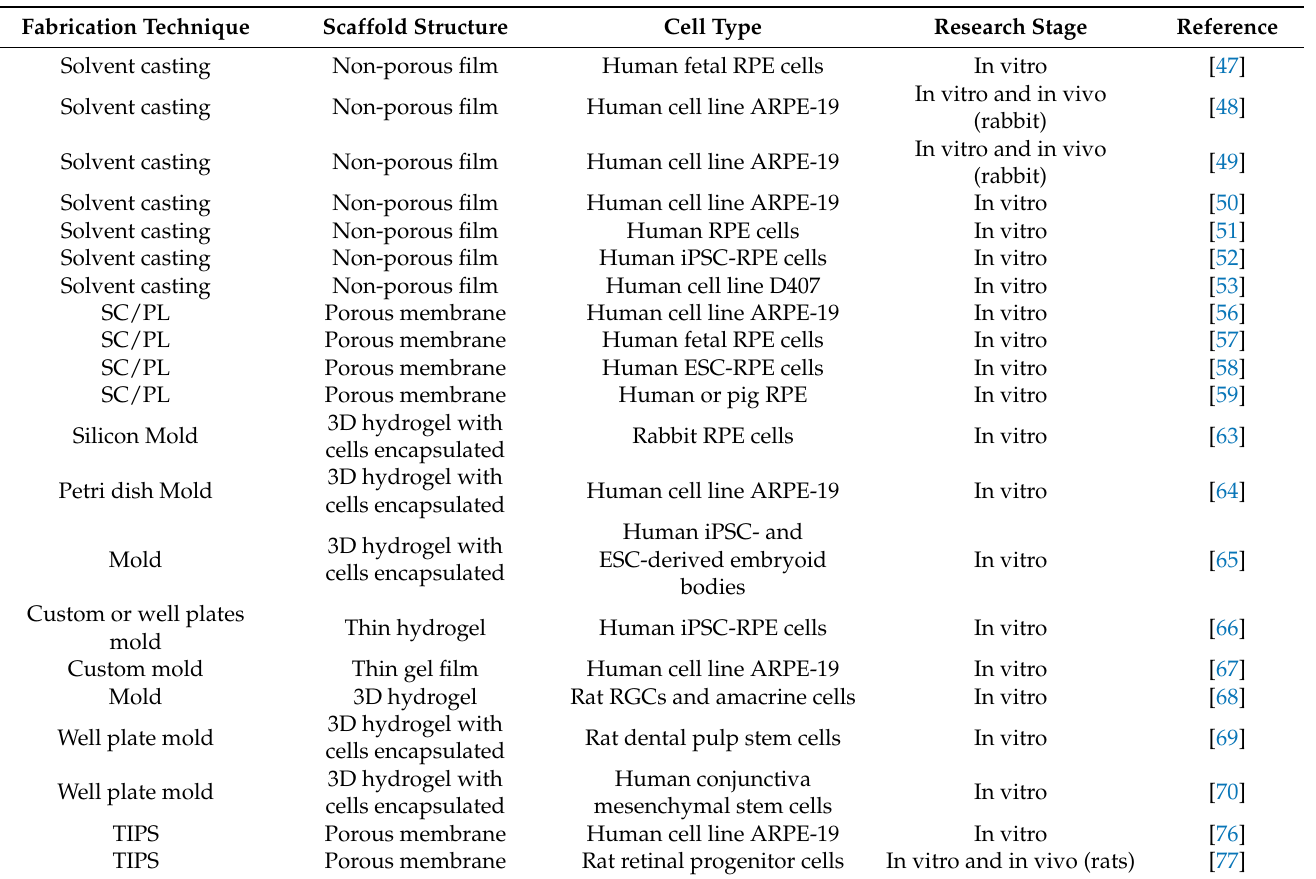
Table 1. A summary of scaffolds produced by conventional methods and used for retinal tissue engineering. This table highlights the fabrication technique, the structure of the scaffold and the cell type used. SC/PL: solvent casting-particle leaching; TIPS: thermally induced phase separation; RPE: retinal pigment epithelium; ESC: embryonic stem cells; iPSC: induced pluripotent stem cells; RGC: retinal ganglion